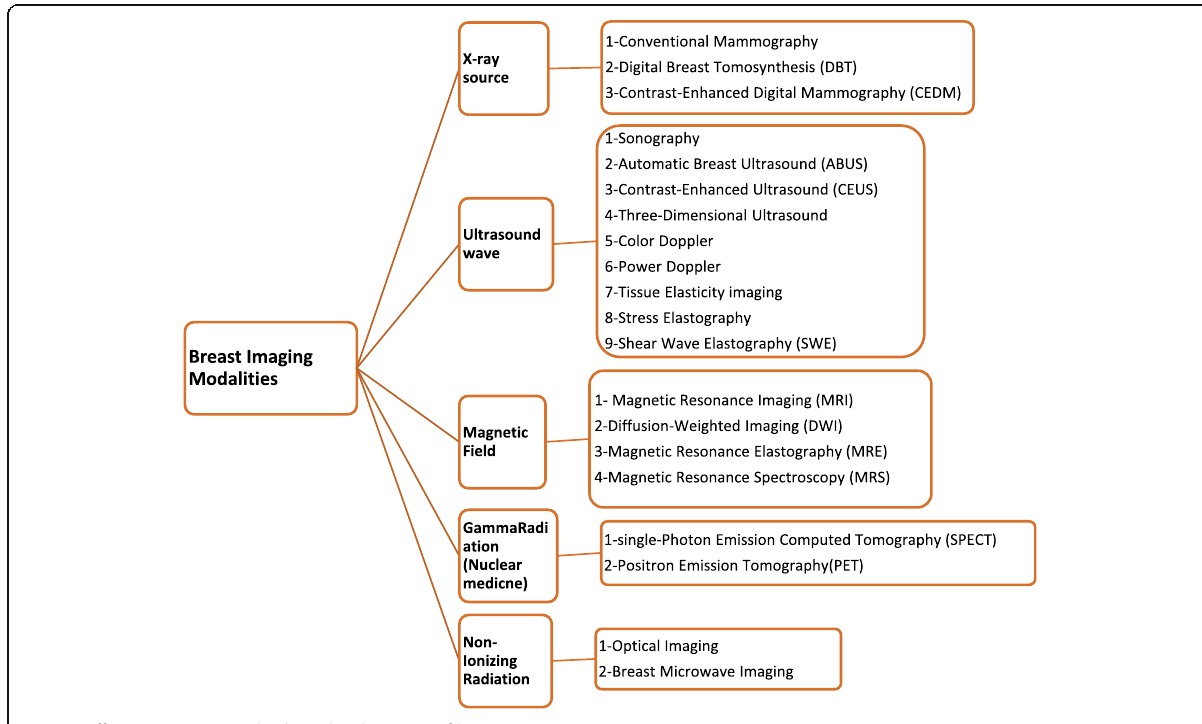
Fig. 1 Different imaging methods in the diagnosis of breast cancer